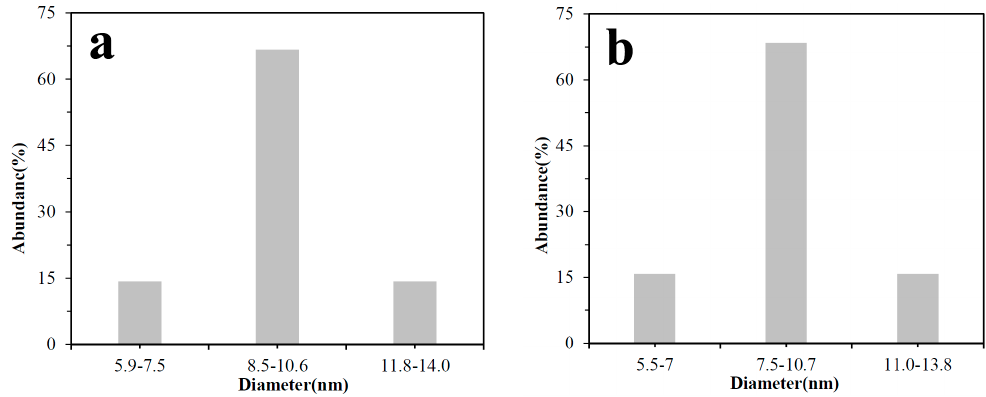
Figure 3. TEM images of the prepared polymer reactors. ( a ) AgHBP-A; ( b ) AgHBP-N; ( c ) HBP-A.